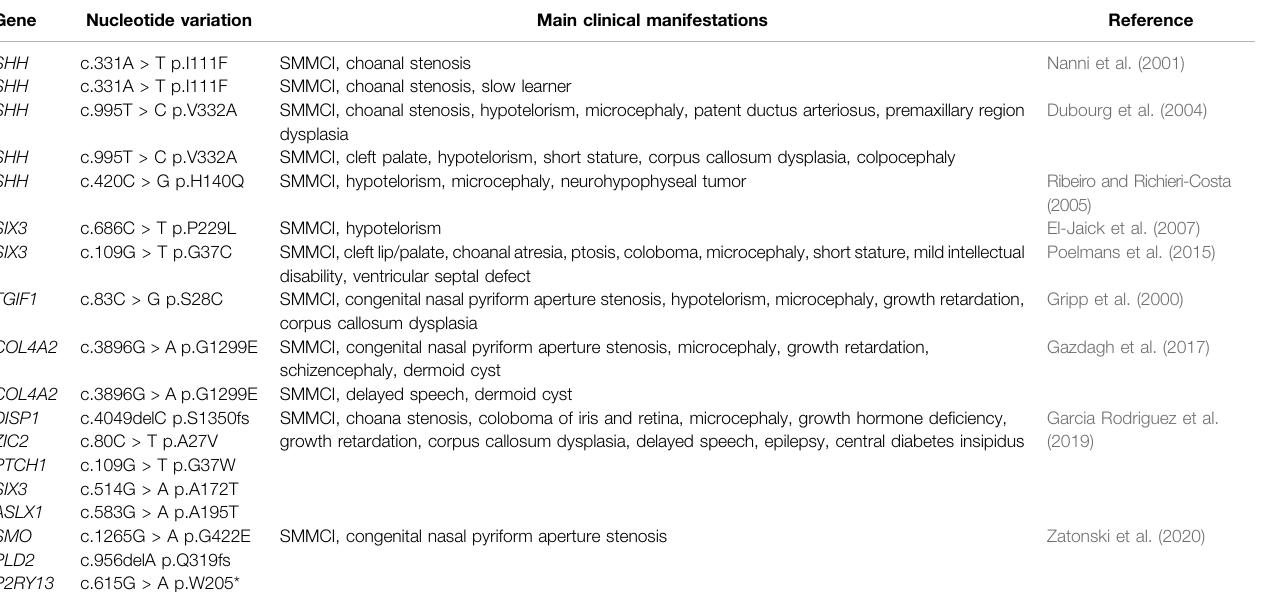
TABLE 3 | Sequence variations found in SMMCI (not HPE) and its main clinical fi